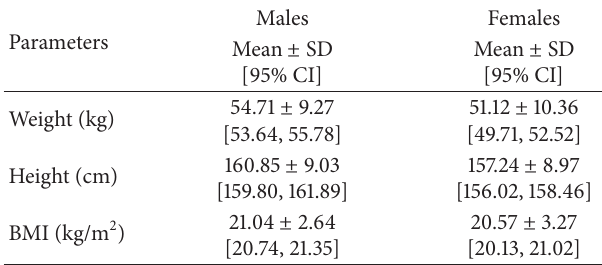
Table 1: Summary of anthropometric measurements per sex of study